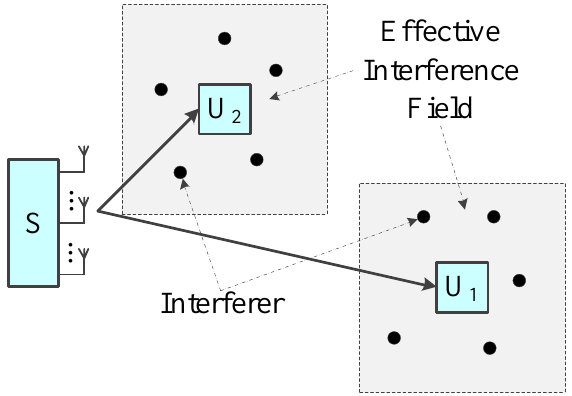
Figure 1. An illustration of the proposed NOMA system in interference-limited